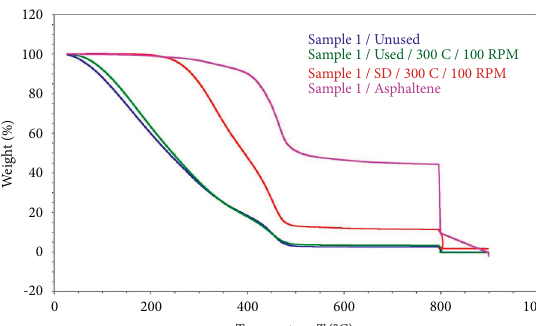
Figure 7: Thermal properties of crude oil, soft deposit, and C asphaltenes at 300 °